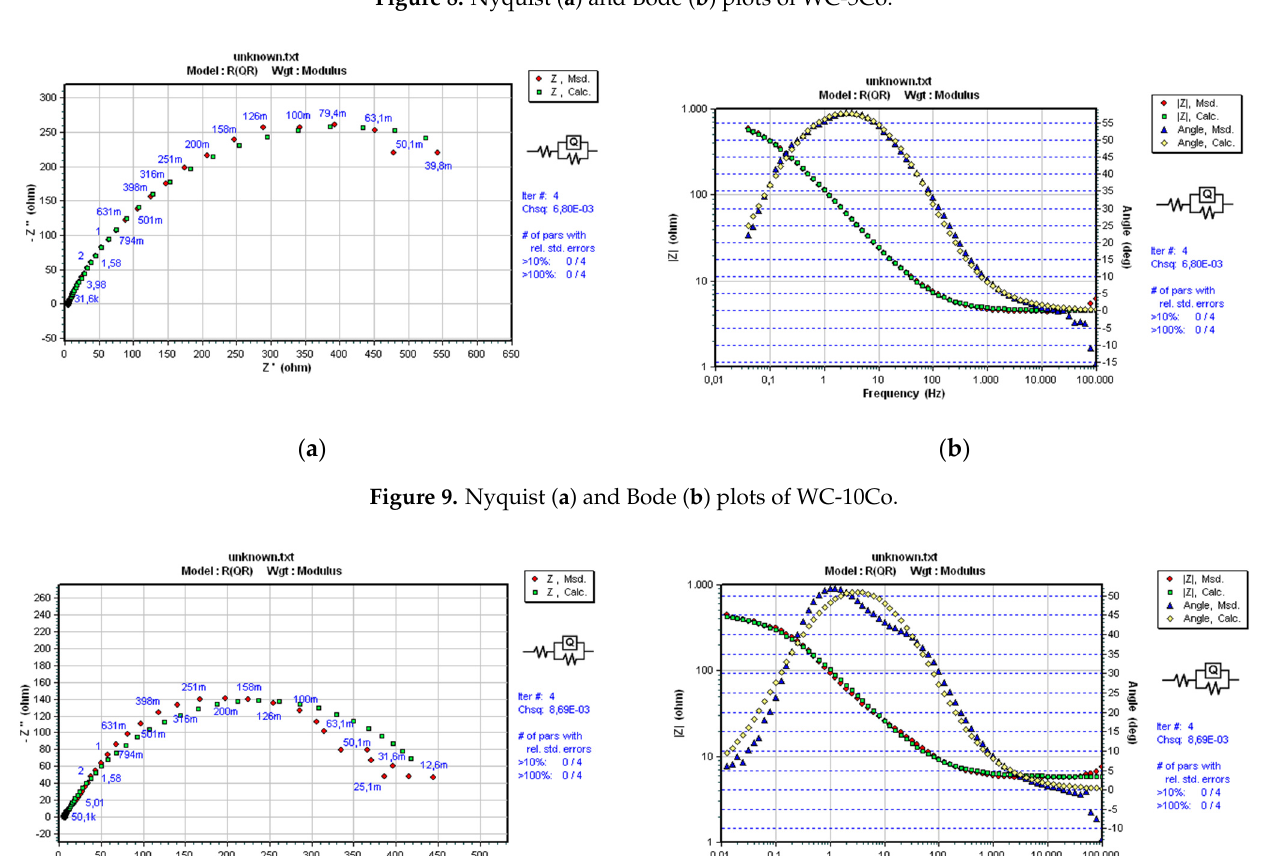
Figure 8. Nyquist ( a ) and Bode ( b ) plots of WC-5Co.